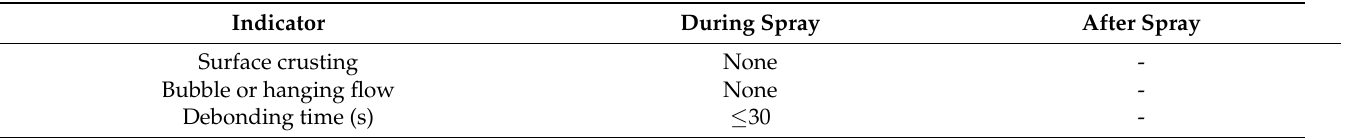
Table 7. Apparent quality in the spraying process and physical properties of the spray after completion. Indicator During Spray After Spray Surface crusting None - Bubble or hanging flow None - Debonding time (s) ≤ 30